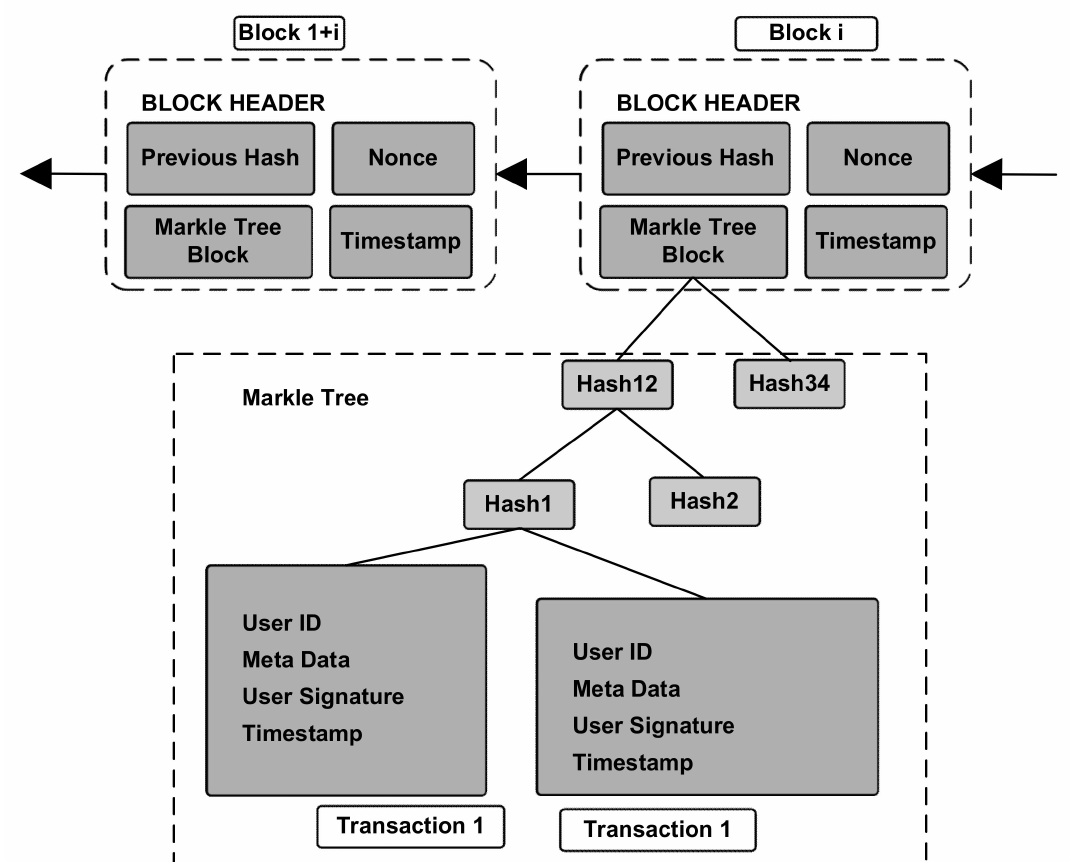
Figure 2. Block structure of